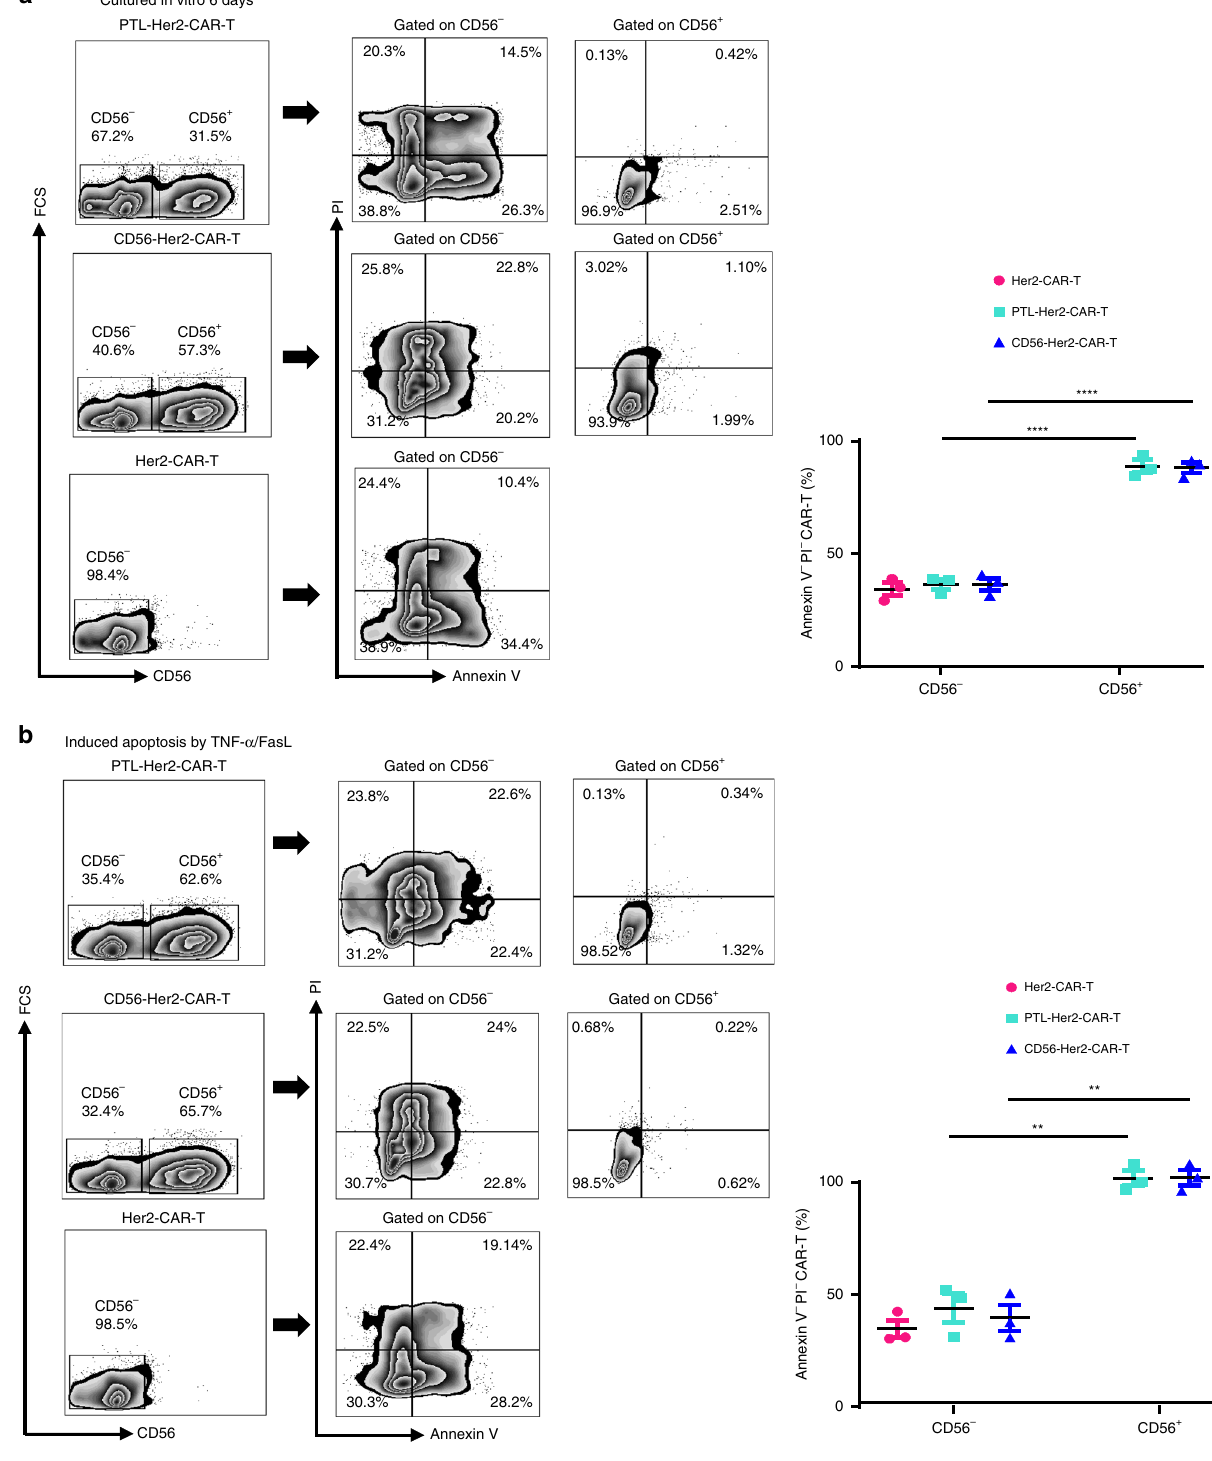
Fig. 6 CD56 enhanced anti-apoptosis capability of CAR-T cells. a Left panel, the representative fl ow plots of apoptotic cell proportion in Her2-CAR-T, PTL- Her2-CAR-T, and CD56-Her2-CAR-T cells after culture for 6 days with cytokine deprivation. Right panel, the percentage of Annexin V − and PI − cells gated as in left panel. b Left panel, the representative fl ow plots of apoptotic cell proportion induced by TNF- α and FasL (10 ng ml − 1 ) in various CAR-T cells. Right panel, the percentage of Annexin V − and PI − cells gated as in the left panel. ** P < 0.01, **** P < 0.0001 (two-tailed Student ’ s t -test). All presented data summarizes mean ± SEM. Data shown are representative data from three independent experiments. The source data underlying a , b are provided as a Source Data fi